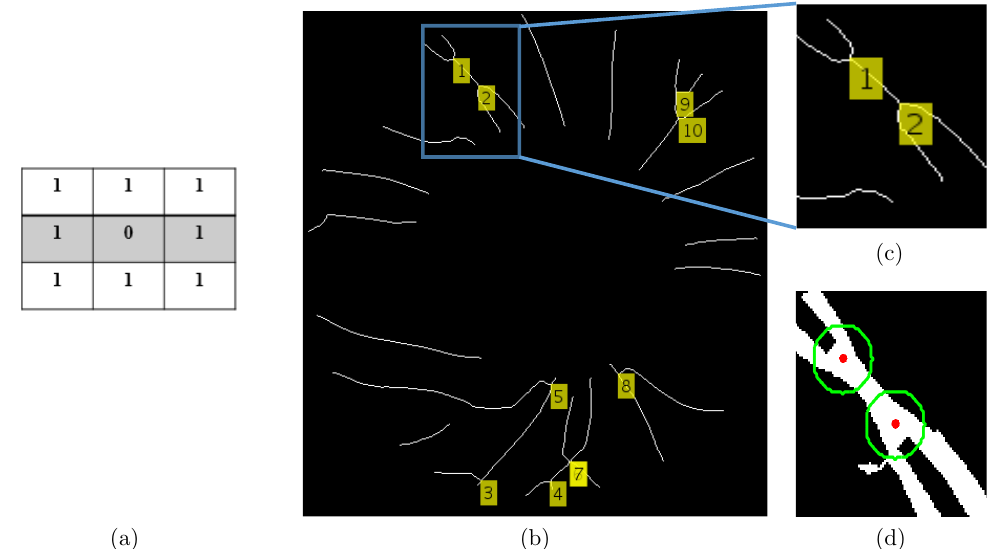
Fig. 10. Detection of vessel junctions. (a) 3 (cid:4) 3 window used to detect the junctions, (b) Location of vessel junctions, (c) An arteriovenous crossing which fakes as two vessel bifurcations and (d) Circular window (in green) centered on junction points in